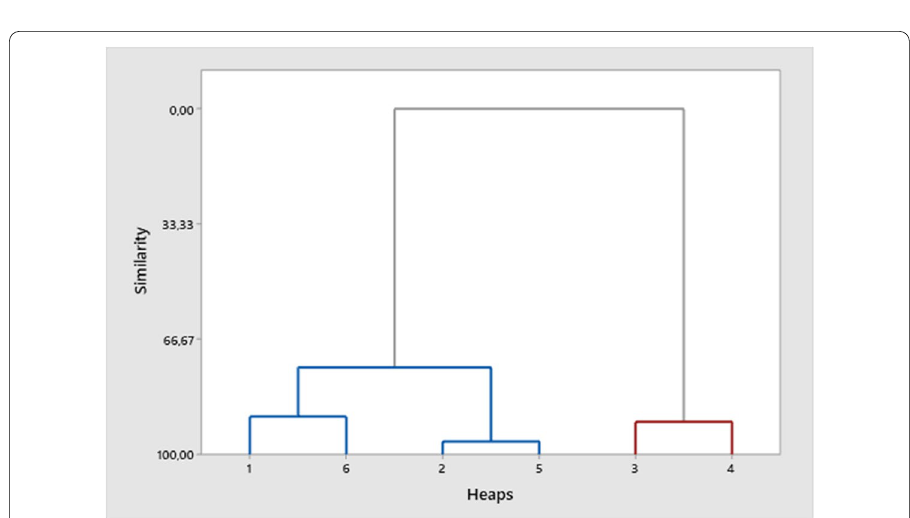
Fig. 14 Dendrogram of heaps 1 to